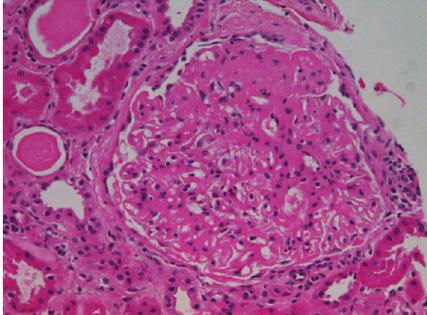
Figure 1: Methenamine silver—periodic acid—Schiff stain ( × 600): theappearanceisdistinctivemotheateninthemesangialmatrixand thickening capillary walls.